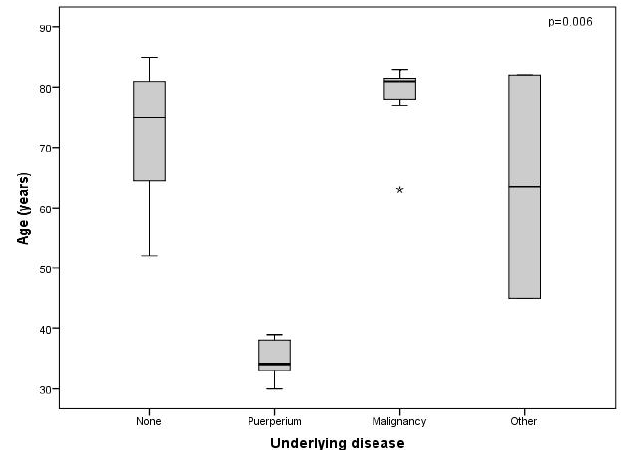
Figure 2. Distribution of patients diagnosed with acquired haemophilia A by underlying condition and age. Independent samples from non-parametric tests: Kruskal–Wallis. “None” is also described as idiopathic in the text. “Other” includes psoriatic arthritis and Paget’s disease. * Isolated case.